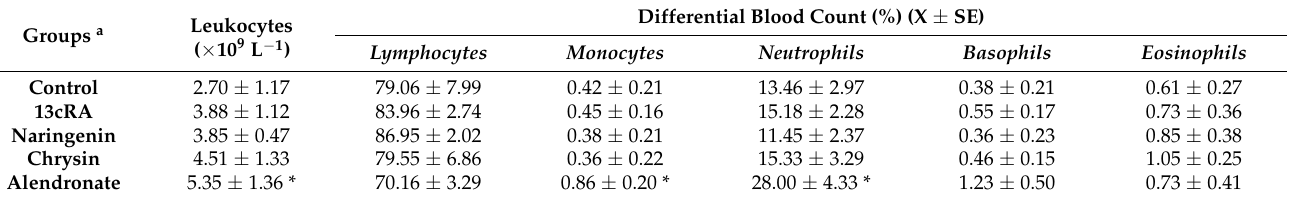
Table 3. Effects of naringenin, chrysin, or alendronate on differential blood count in rats with retinoic-acid-induced